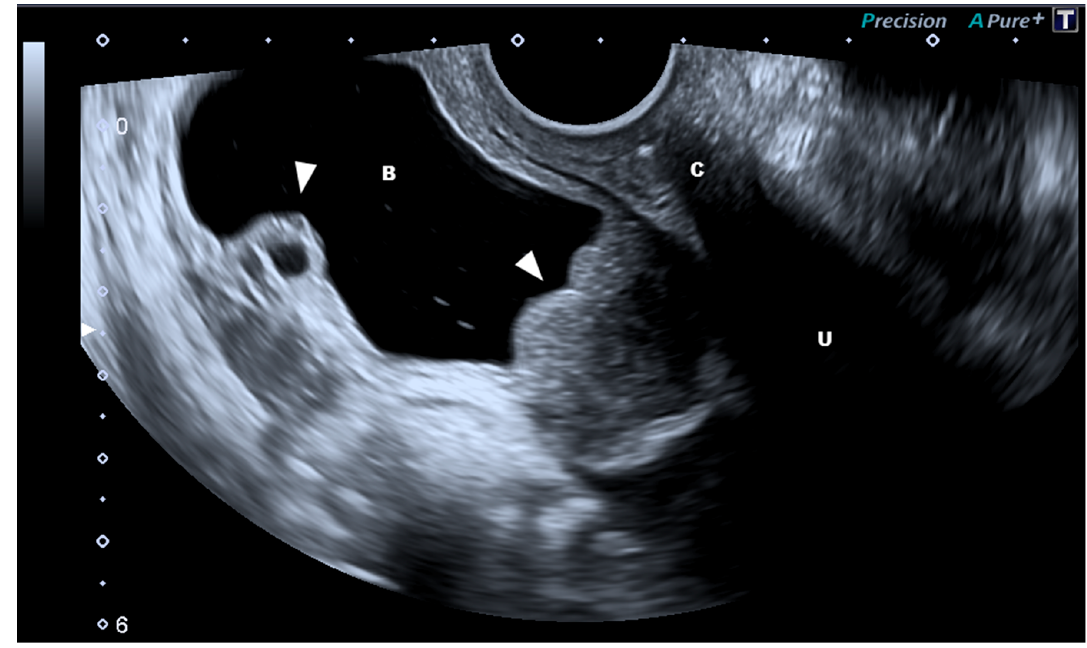
Figure 2. Bifocal endometriosis of the bladder (arrow). The two lesions present different characteristics as the one on the right-hand side presents a typical solid aspect while the left one is a cystic endometriosis location. Abbreviations: B, bladder; C, cervix; U, uterus.